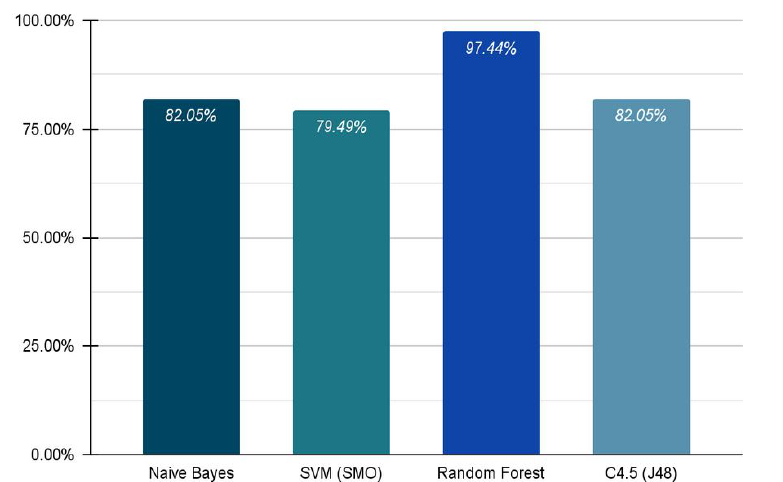
Figure 7. Comparison of the classification algorithms with the studied features and the accuracy